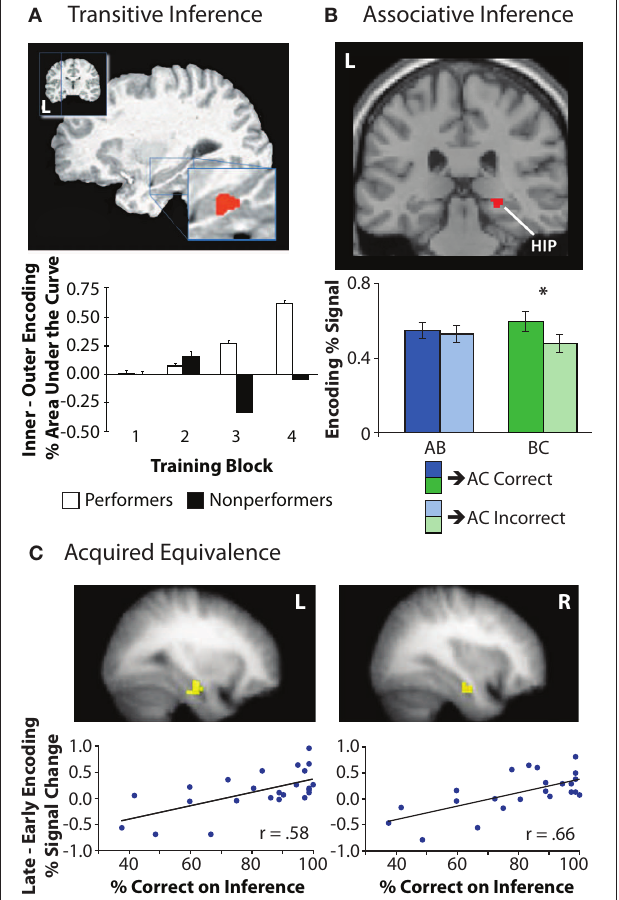
FIGURE 5 | Hippocampal encoding activation during inferential reasoning tasks. (A) Left hippocampal activation increased across training block for inner pairs in the transitive hierarchy (B > C) relative to outer pairs (A > B), but only for those participants who were successful on the inferential test. Adapted by permission from Greene et al. (2006), copyright 2006 MIT Press. (B) In an associative inference task, right hippocampal activation during encoding of overlapping associations (BC) was greater for trials in which the corresponding inference judgment (AC) was later correct relative to trials on which the inference judgment was later incorrect. Hippocampal activation during initially acquired associations (AB) was not related to subsequent inferential performance. Adapted from Zeithamova and Preston (2010). (C) Activation in left and right hippocampus during the training phase of an acquired equivalence task was correlated with individual differences in inference performance. Specifically, increases in bilateral hippocampal activation from the early to late portion of the training phase were associated with superior performance on inferential probe trials. Adapted by permission from Shohamy and Wagner (2008), copyright 2008